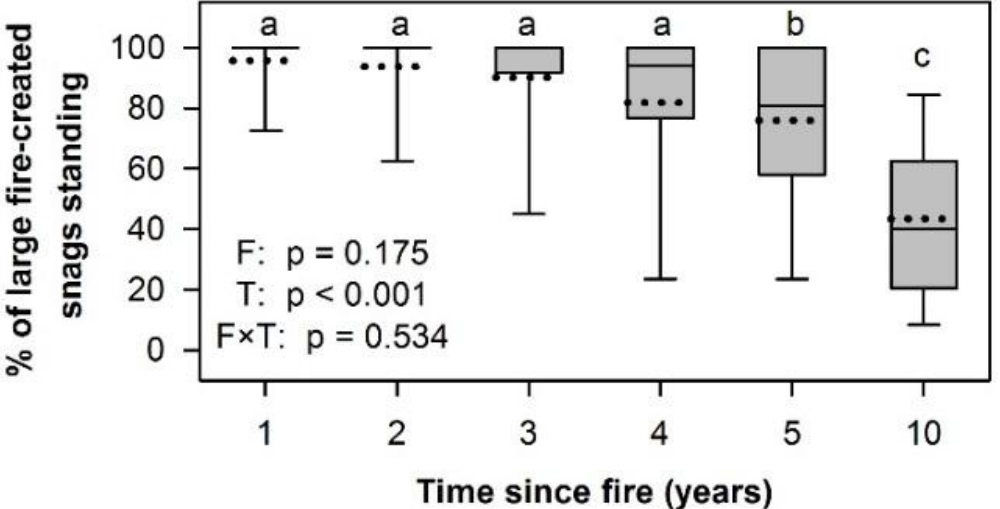
Figure 4. Persistence of large (>20 cm diameter at breast height (DBH)) fire-created snags with respect to time since fire. Boxes represent 25th, 50th, and 75th percentiles, whiskers represent 10th and 90th percentiles, and dotted lines represent means. The p -values are model results for the effects of fire severity (F), time since fire (T), and their interaction (F×T). Letters separate means though time.